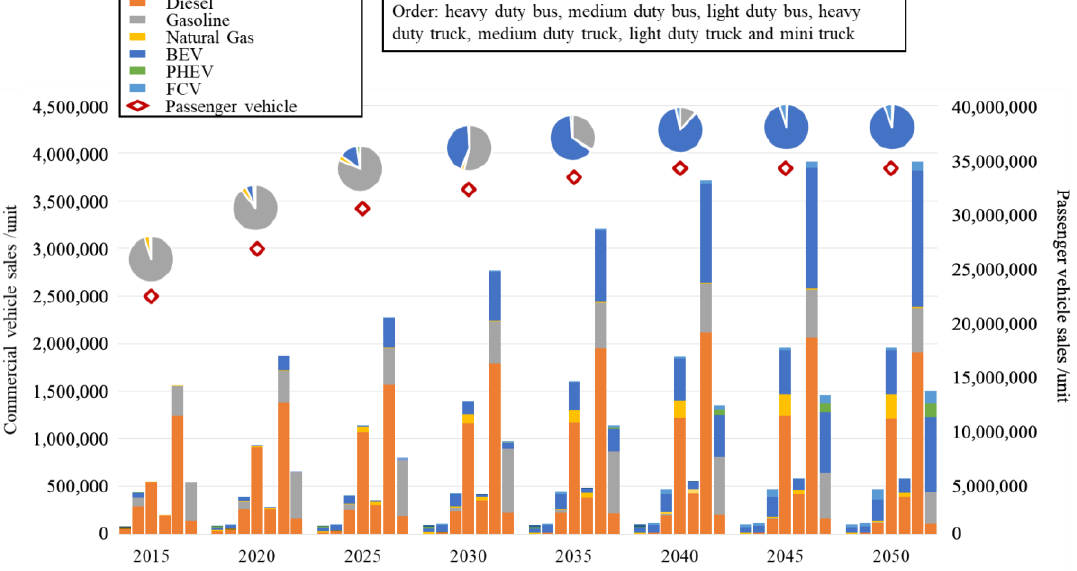
Figure 6. Vehicle sales under BAU scenario.